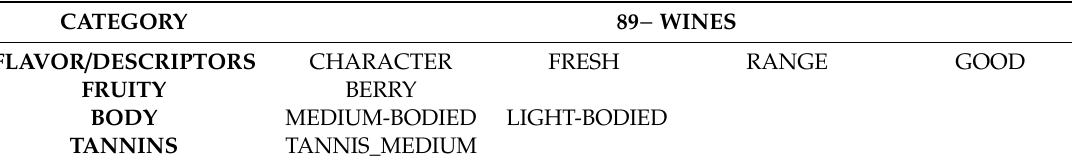
Table 8. Distinct keywords between 90 + and 89 − wines from 1855 Bordeaux Wine O ffi cial classification dataset in 89 −